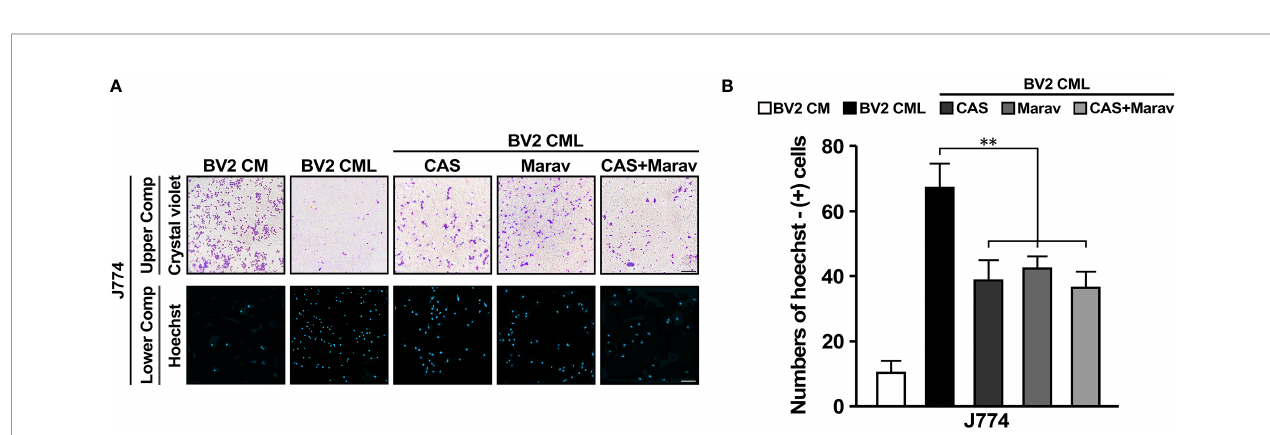
FIGURE 3 | CCR4 and CCR5 antagonists interrupt migration in BV2 CML. (A) J774 cells in the upper compartment of the transwell system are identi fi ed using crystal violet staining and using Hoechst staining in the lower compartment. (B) The number of J774 cells migrating to the lower compartment is con fi rmed by quantitative analysis. CAS, Marav, and CAS+Marav groups in BV2 CML show signi fi cantly lower J774 migration than did not treat antagonist group in BV2 CML (n=3/group, **P<0.05, scale bar=10